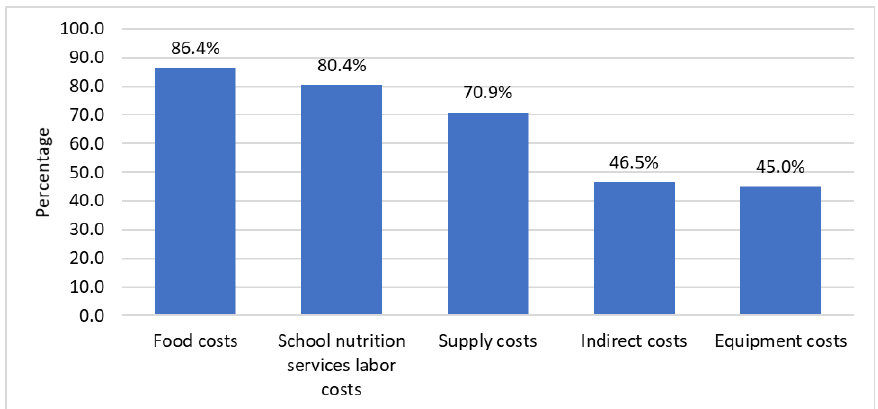
Figure 5. Main factors reported in driving the foodservice deficit for Californian school food authorities in the SY 2021 – 22 ( n = 271). Stratified analyses showed SFAs with more than 40% of their students eligible for FRPMs reported that their finances were more affected by supply costs than SFAs with 40% or fewer eligible FRPM students ( p = 0.03) (Table 5). SFAs in non-urban areas reported that their finances were more affected by food costs and supply costs than SFAs in urban areas ( p < 0.05). Medium and large SFAs reported that their finances were more affected by supply costs in comparison with small SFAs ( p- value for pairwise comparisons < 0.025).